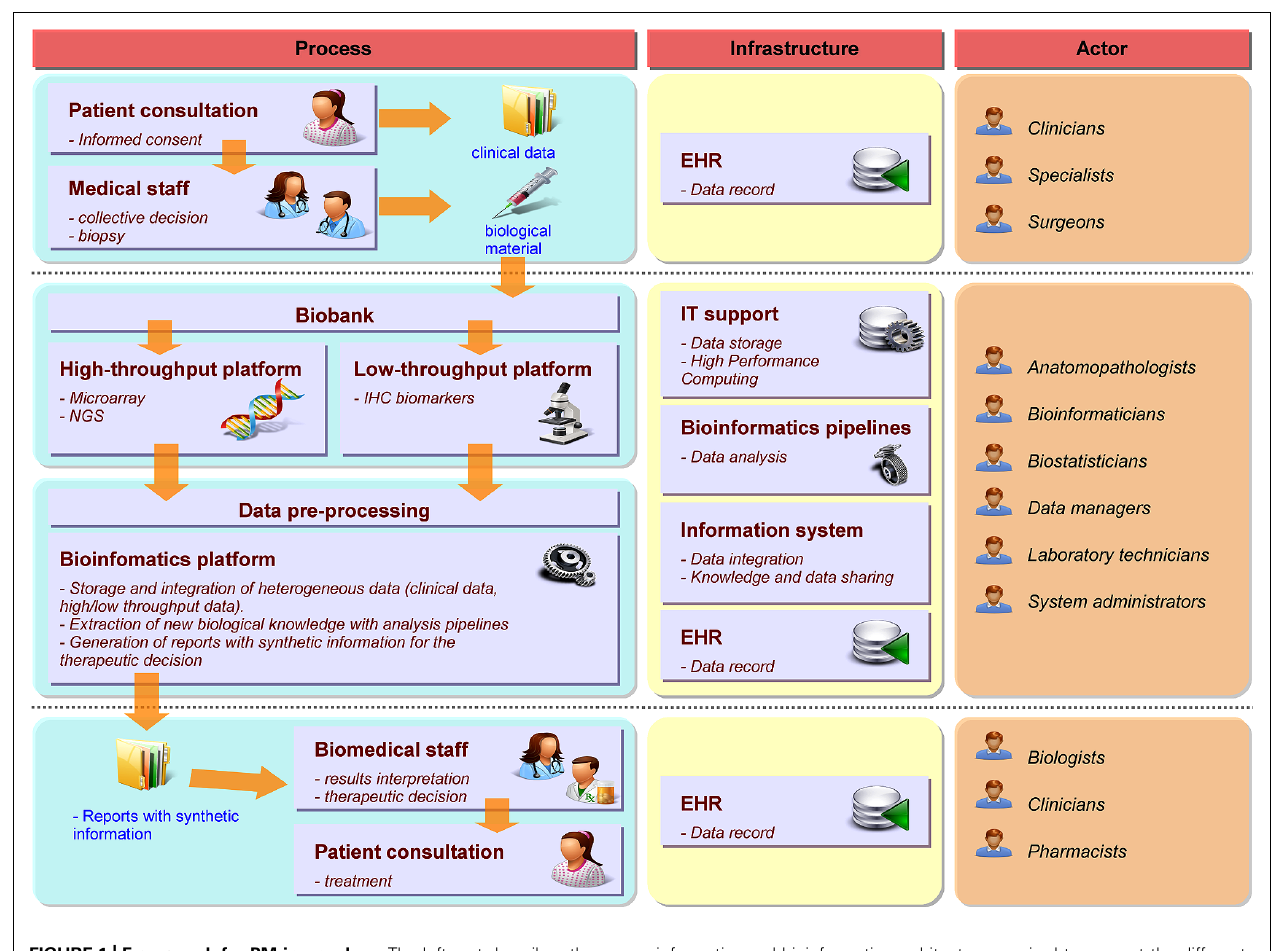
FIGURE 1 | Framework for PM in oncology. The left part describes the workflow and processes required for the decision-making from patient consultation to the therapeutic decision. The middle part focuses on the